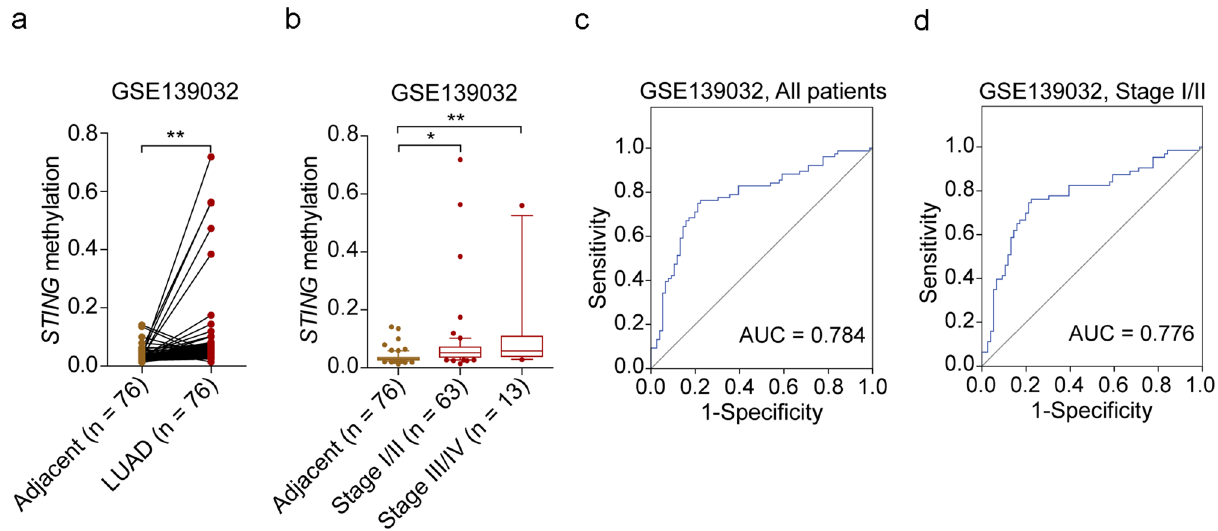
Figure 4. The discriminative potential of STING methylation in LUAD. ( a, b ) STING methylation status in all LUAD patients ( a ) and early-stage (Stage I/II) and advanced-stage (Stage III/IV) patients ( b ) was investigated in GSE139032. ( c , d ) ROC analysis of STING methylation in all patients ( c ) and early-stage patients ( d ) in GSE139032. Box-and-whisker plot ( b ) shows the median and 10–90th percentile of the STING methylation values. * P < 0.05, ** P < depth (HR = 1.903, 95% CI: 1.184–3.056, P = 0.008) and lymph node metastasis (HR = 2.310, 95% CI: 1.585–3.365, P < 0.001), and also STING methylation (HR = 2.927, 95% CI: 1.984–4.321, P < 0.001) remained the independ-